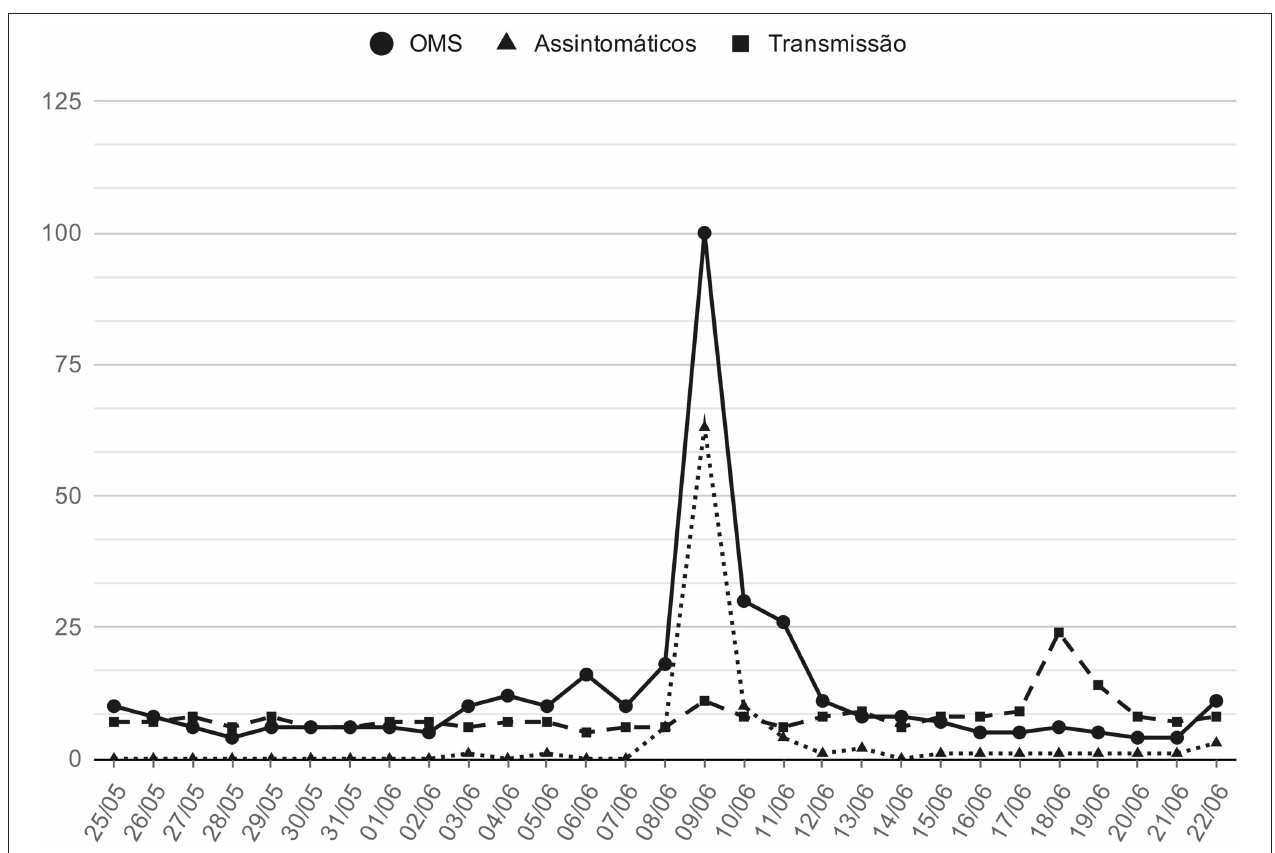
FIGURE 4 | Google Trends YouTube Search for “protest + protests” and “nurse + nurses” between 4/17/20 and 5/22/20. https://trends.google.com/trends/explore? date=2020-04-01%202020-05-20&geo=BR&gprop=youtube&q=protesto%20%2B%20protestos,enfermeiros%20%2B%20enfermeiro.